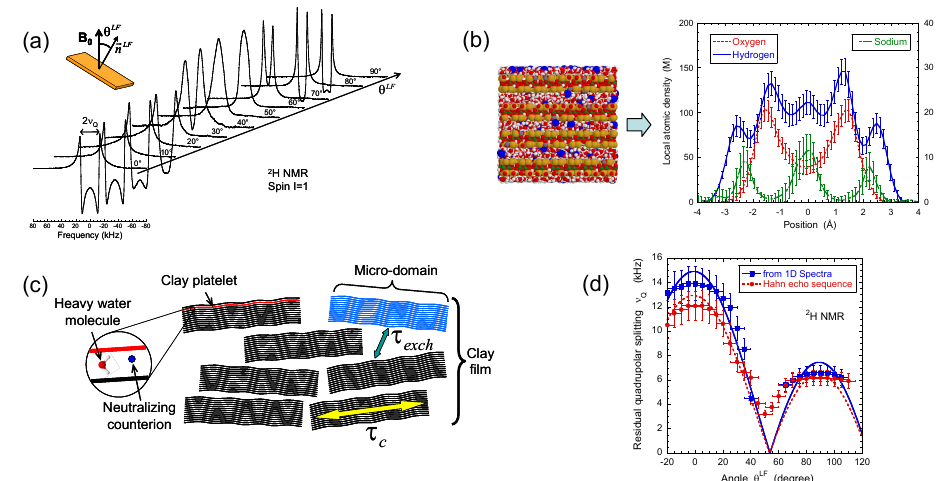
Figure 2. ( a ) 2 H NMR spectra as a function of the film orientation θ LF in the static magnetic field B 0 ; ( b ) Snapshot illustrating one grand canonical Monte Carlo (GCMC) equilibrium configuration of confined water molecules and neutralising sodium counterions from which one can deduce concentration profiles of sodium counterions with oxygen and hydrogen atoms pertaining to water molecules confined between two beidellite clay lamellae; ( c ) Schematic view of multi-scale organisation of the clay sediment resulting from the coexistence of clay aggregates with various orientations of the platelet directors; ( d ) Variation of the residual quadrupolar coupling ν Q extracted from the 2 H NMR spectra and the Hahn echo sequence as a function of the film orientation θ LF in the static magnetic field B 0 . Reprinted with permission from [23]. Copyright (2014) American Chemical Society.